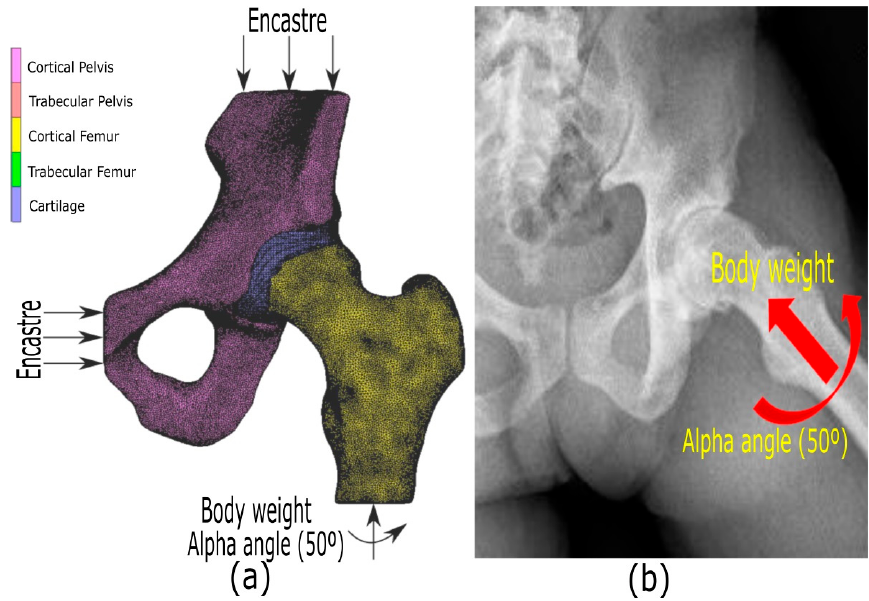
Figure 6. ( a ) Proposed Cam-type FE model with the applied boundary conditions and ( b ) radio- graph of the patient´s hip joint including a displacement and rotation of 50° of the femur in the Cam-type hip